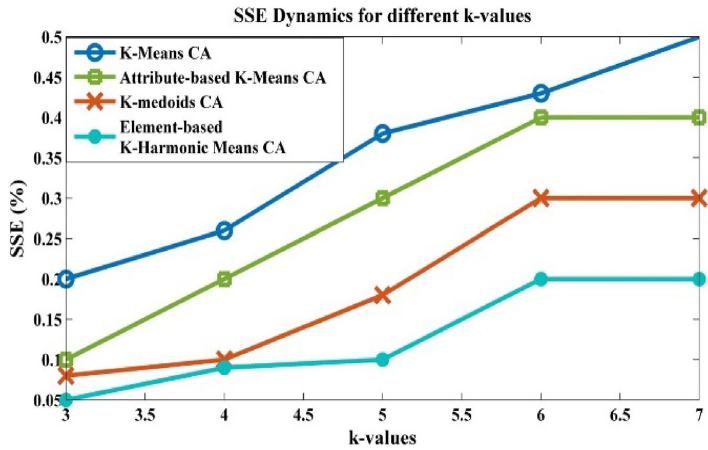
Figure 9. The effect of the number of clusters on the performance is presented.